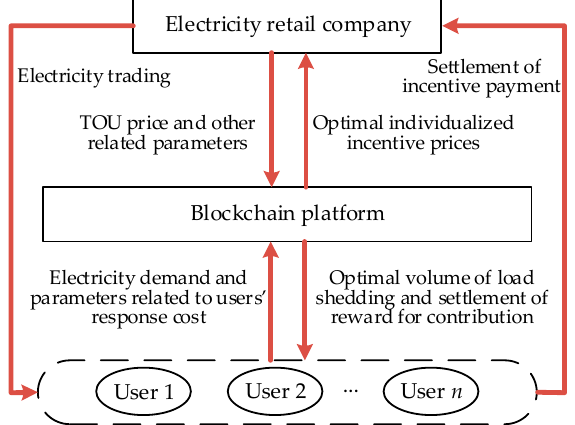
Figure 1. The overall framework of the blockchain-enabled DR scheme.